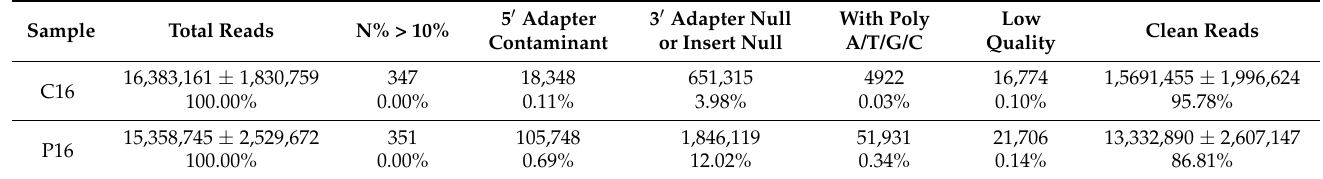
Figure 2. CD63 levels in pregnant and non-pregnant endometrium. ( A ) Expression pattern of CD63 in pregnant and non-pregnant endometrium. Scale bar = 200 µ m. ( B ) Quantitative analysis of CD63 by measuring the average integrated optical density (IOD) in LE and GE of pregnant and non-pregnant endometrium. Data are shown as the mean ± SEM values ( n = 3). Legend: C16, on day 16 of the estrous cycle; P16, on day 16 of pregnancy; LE, endometrial luminal epithelium; GE, glandular epithelium. ** p < 0.01 was considered especially significant. Table 1. Summary of sequencing data